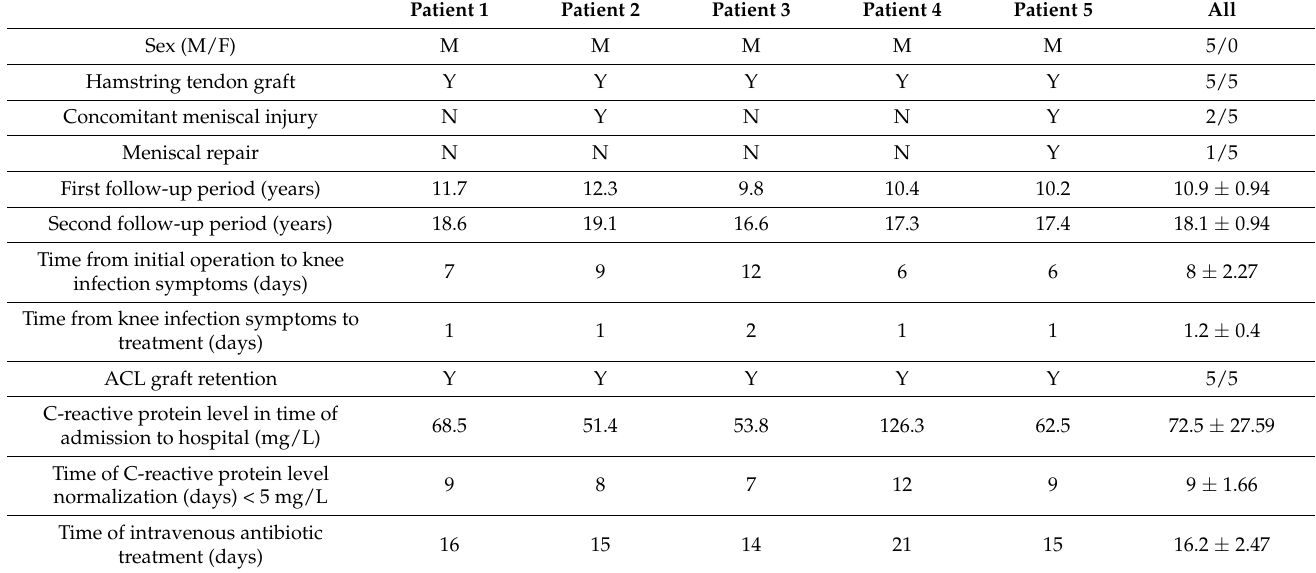
Table 1. Baseline characteristic of the